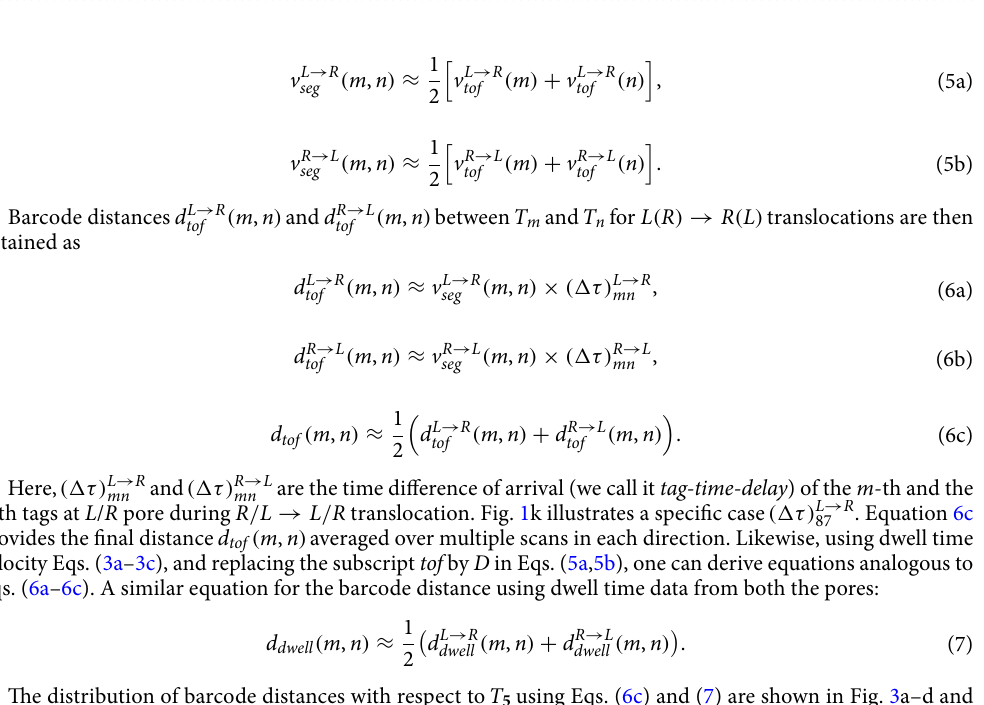
Figure 3. Barcodes generated using ( a ) Eq. (7) and ( c ) Eq. (6c). Colored symbols/lines refer to the barcodes T 1 , T 2 , T 3 , , T 4 , T 6 , T 7 , and T 8 calculated w.r.t T 5 . The open/filled symbols correspond to R / L → L / R translocation. For better visualization, every 6th data point is shown. The solid/dashed colored lines in ( b ) and ( d ) are the exact and the calculated barcodes averaged over 300 scans. Figures ( e , f ) Barcodes generated using different methods using tof velocity